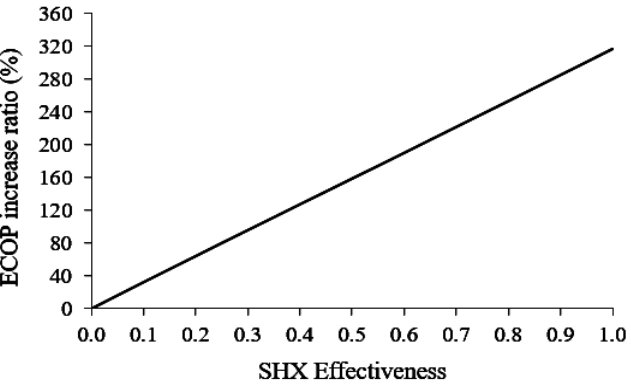
Figure 32. ECOP increase ratio as a function of ε SHX .